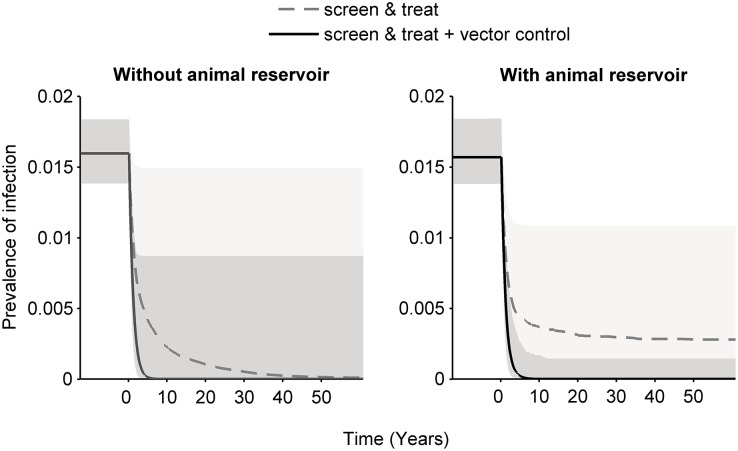
Median (lines) and 95th percentiles (shaded areas) of simulations on the impact of interventions on prevalence over time in high transmission settings without (left) and with (right) animal-tsetse transmission, assuming a range of efficacies for screen & treat (solid line) and screen & treat with vector control (dashed line).